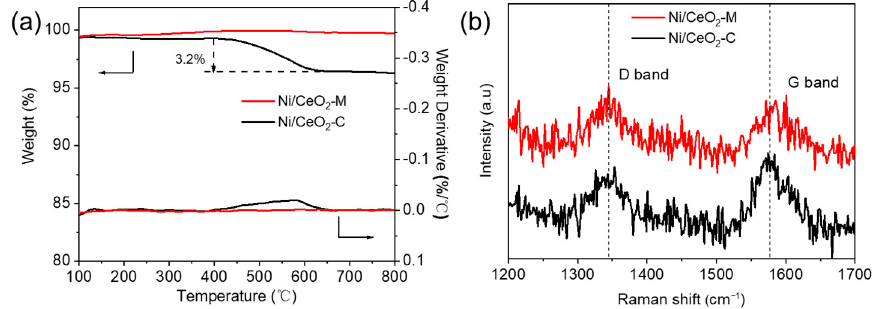
Figure 5. ( a ) TGA − DTG result and ( b ) Raman spectra of Ni/CeO 2 -C and Ni/CeO 2 -M catalysts.